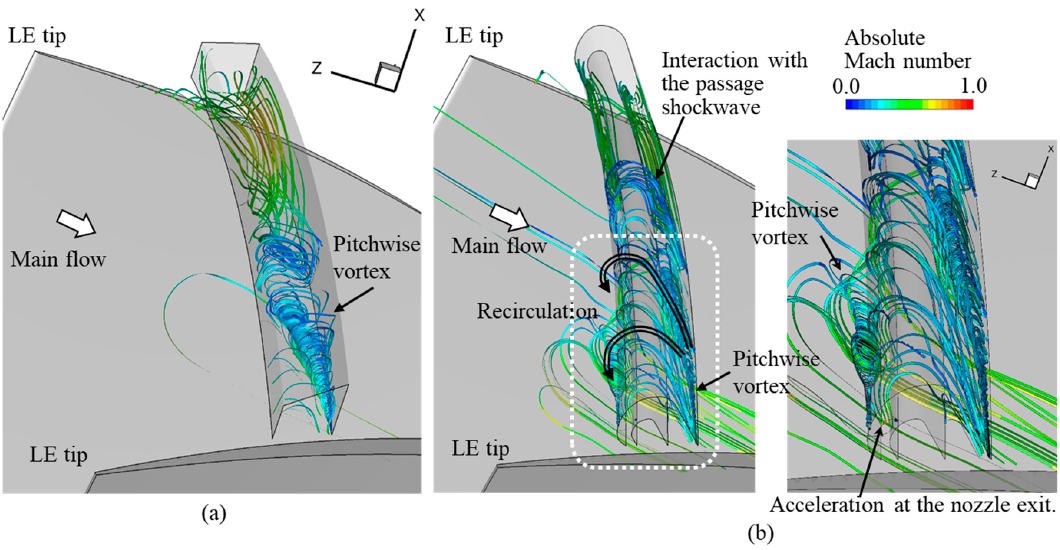
Figure 13. Streamlines showing the flow structure inside two different casing treatments. ( a ) Square groove (OP-D); ( b ) recirculation groove (OP-D).